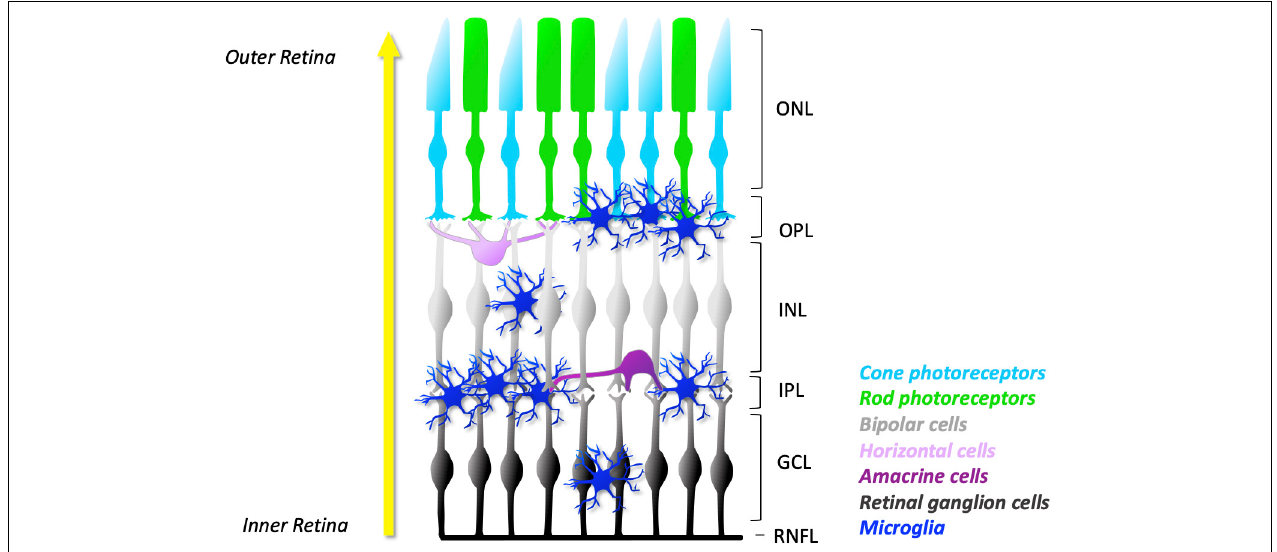
FIGURE 1 | Schematic representation of microglial distribution in layers of normal mature retina. As development progresses, microglia migrate from the GCL and IPL towards the outer layers of the retina (yellow arrow). In the young retina, the number of microglia in their ramified appearance is found predominantly in the synaptic layers: the OPL and IPL. They can also be found in lesser numbers in the GCL and INL. However, no microglia are found in the ONL, a specialised microglial exclusion zone. The concentration of microglial processes in the plexiform layers facilitates frequent and dynamic contact with neuronal dendrites, axons, and synapses. The ramified morphology allows microglia to constantly extend and retract their processes. Together, these features facilitate constant surveillance of the surrounding microenvironment. ONL, outer nuclear layer; OPL, outer plexiform layer; INL, inner nuclear layer; IPL, inner plexiform layer; GCL, ganglion cell layer; RNFL, retinal nerve fibre